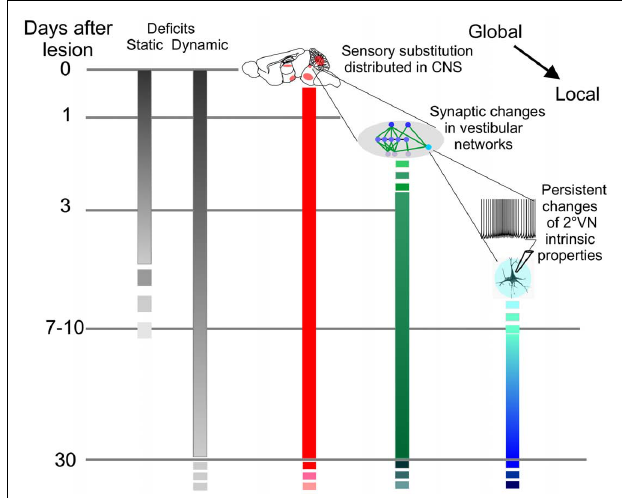
FIGURE 4 | Dynamic of vestibular compensation and neural correlates. Compensation of static and dynamic deficits is presented in gray scales. Static deficits get compensated in about a week while dynamic compensation follows a slower time course over several months or years. Neural correlates associated to sensory substitution (red) depend on structures distributed throughout the entire central nervous system (CNS) and encompass all kinds of structural plasticities. Synaptic (green) and intrinsic (blue) scales represent the neural correlates at the level of the vestibular nuclei based on in vitro works.With time, deeper modifications are engraved within the finer parts of the vestibular-related networks. Importantly, there is no causal relationship postulated between the parallel processes. Instead, the hypothesis is to be understood as a “basic reaction pattern” which includes all the cellular events initially triggered by the